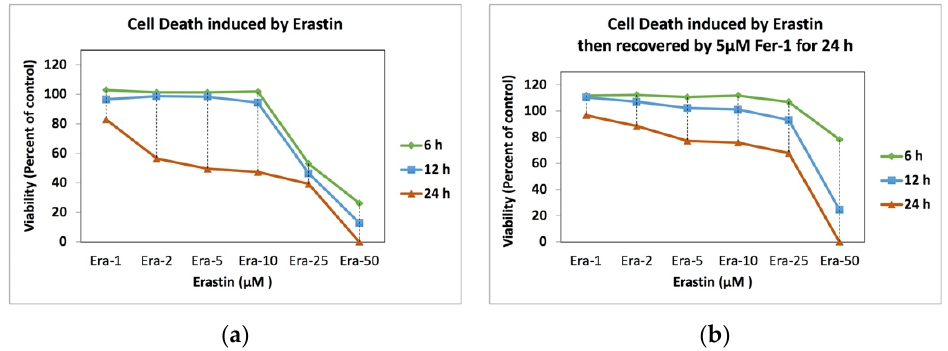
Figure 6. Cell death recovery before and after Fer-05 containing medium replacement: ( a ) induced by Era-0, Era-01, Era-02, Era-05, Era-10, Era-25, and Era-50 and ( b ) recovered by Fer-05 after the erastin-induced cell death.